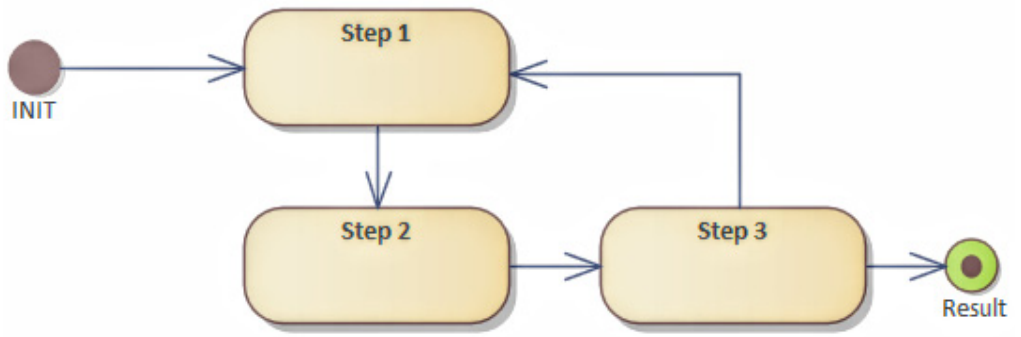
Figure 12. High level finite state machine.